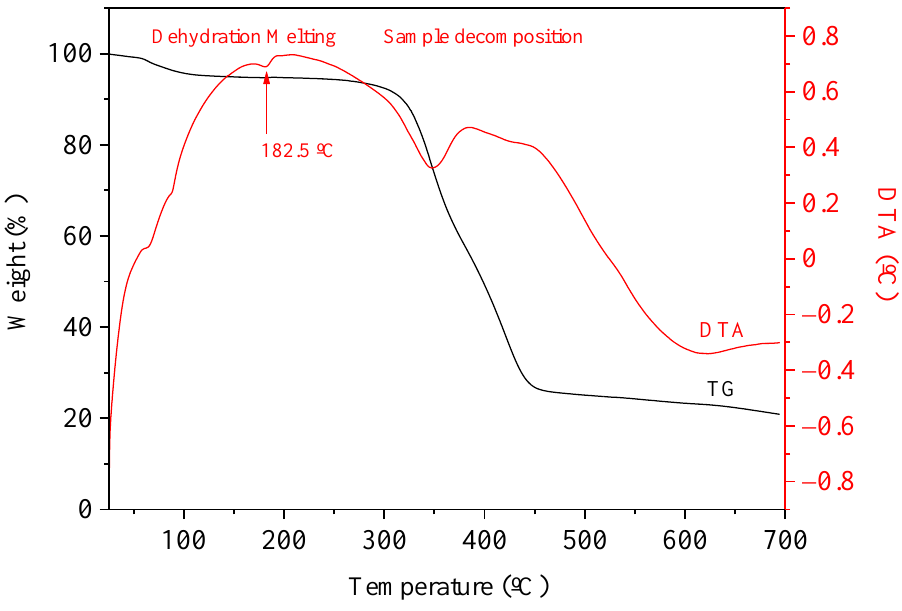
Figure 5. Differential thermal/thermogravimetric analyses of (CHBMAH 2 )ZnBr 4 · 3/2H 2 O 1 .